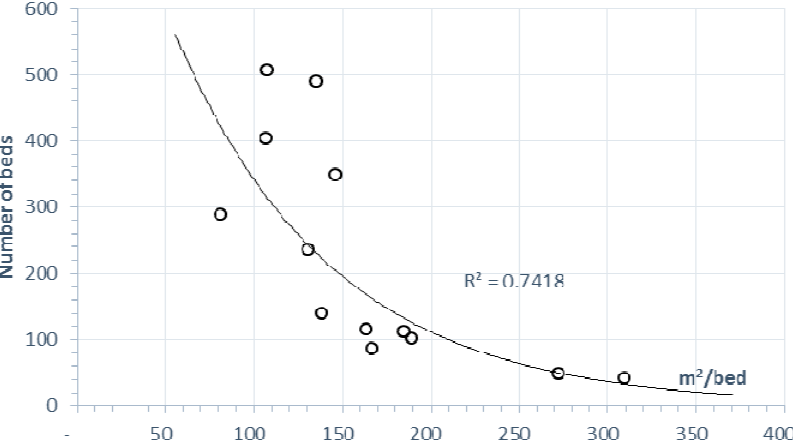
Figure 2. Relationship between the number of beds and the built surface area per bed.